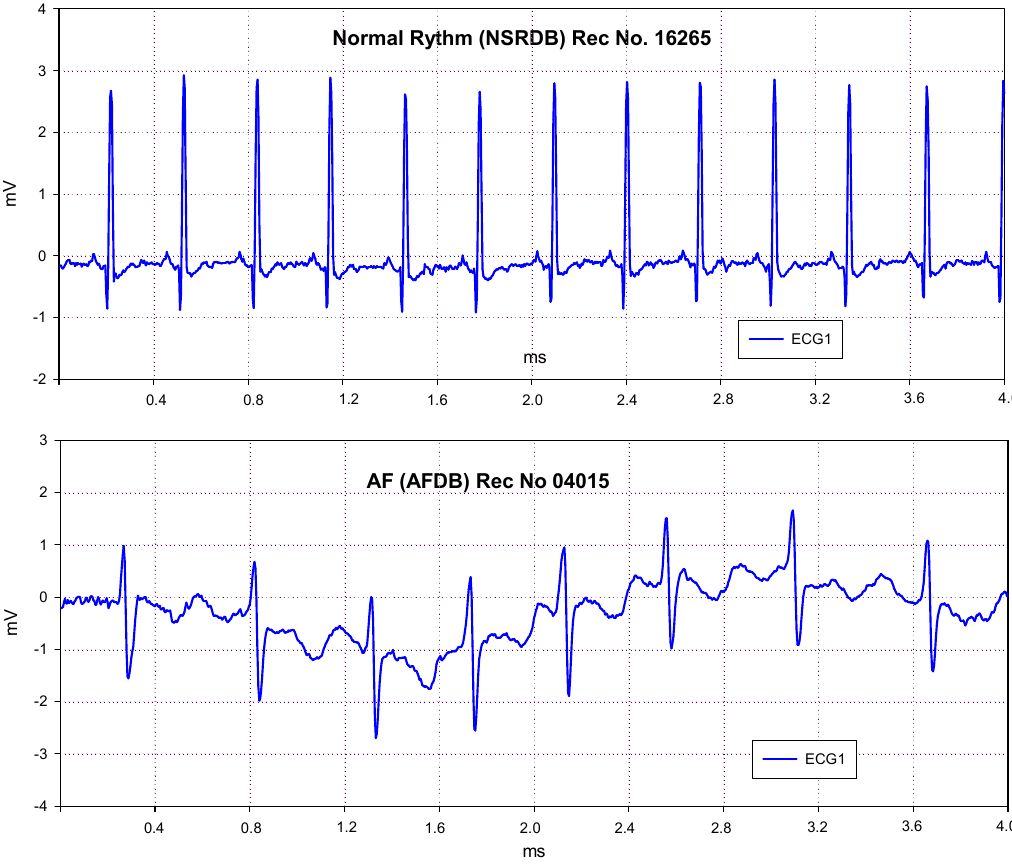
Figure 4. Raw data (normal and AF segments).